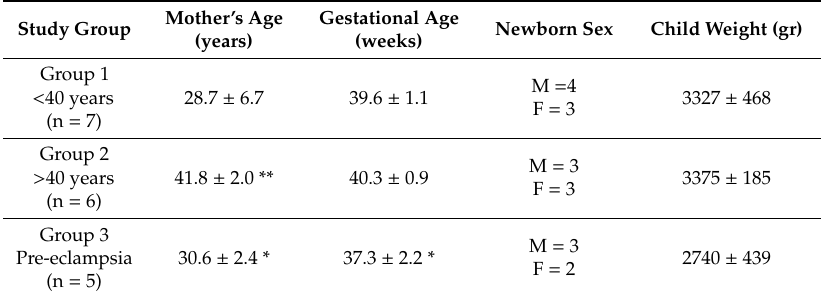
Table 1. Characteristics of pregnancies considered in this study.